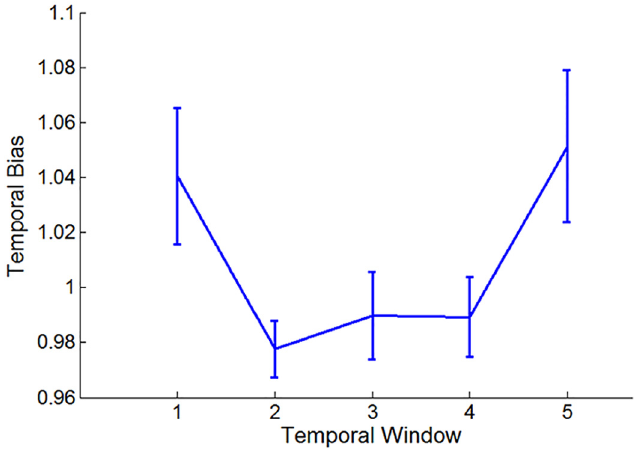
Fig 5. Temporal weighting profile for the 3-sec perceptual decisions in experiment-2 and 3 (data collapsed). Error bars denote 1 within-participant S.E.M